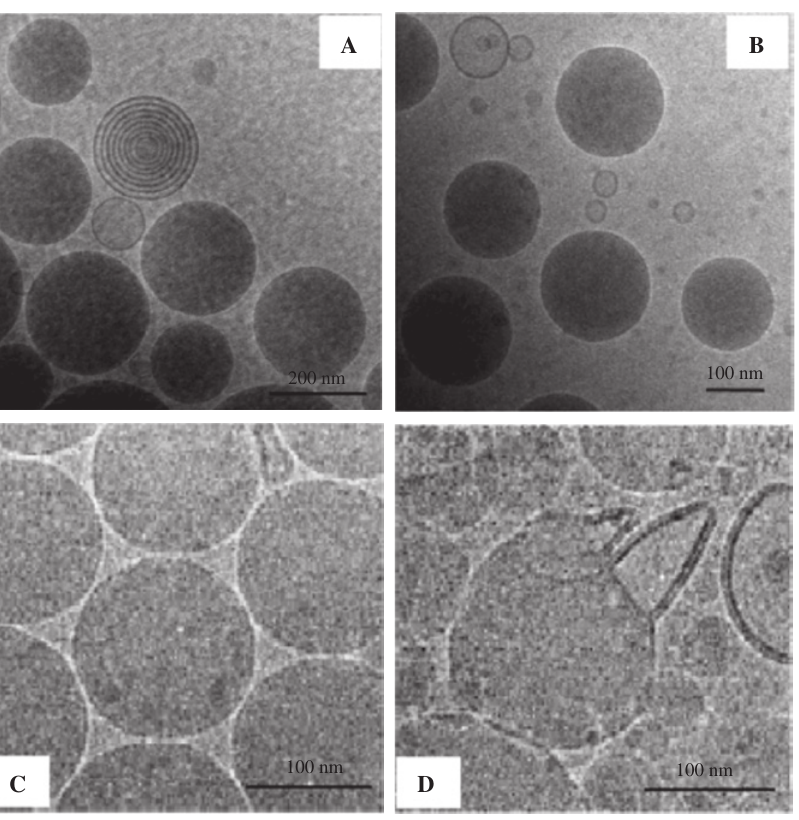
Figure 6: Images of colloidal fat emulsions obtained by cryo-TEM: (A) Lipofundin ® 20% N, (B) Lipofundin ® MCT 20%, (C and D) triglyceride emulsions stabilized with egg yolk lecithin alone (C) and with the admixture of stearylamine for surface modification (D). Reprinted from Kuntsche et al. [7].